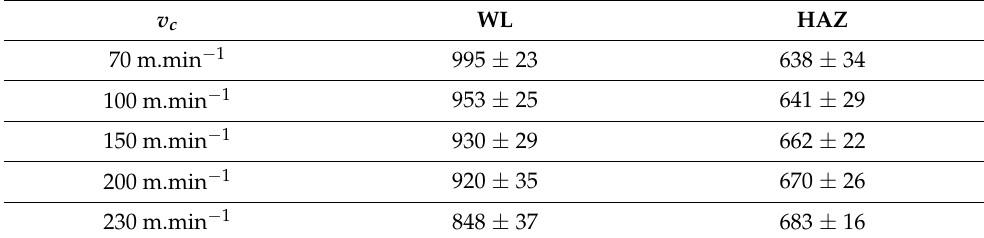
Table 5. HV0.05 for WL and HAZ as a function of cutting speed, VB = 0.8 mm, bulk HV0.05 726 ±